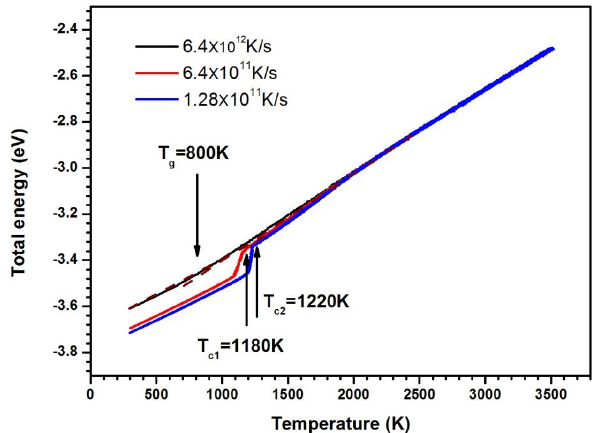
Figure 1. The average atom energy as a function of temperature.